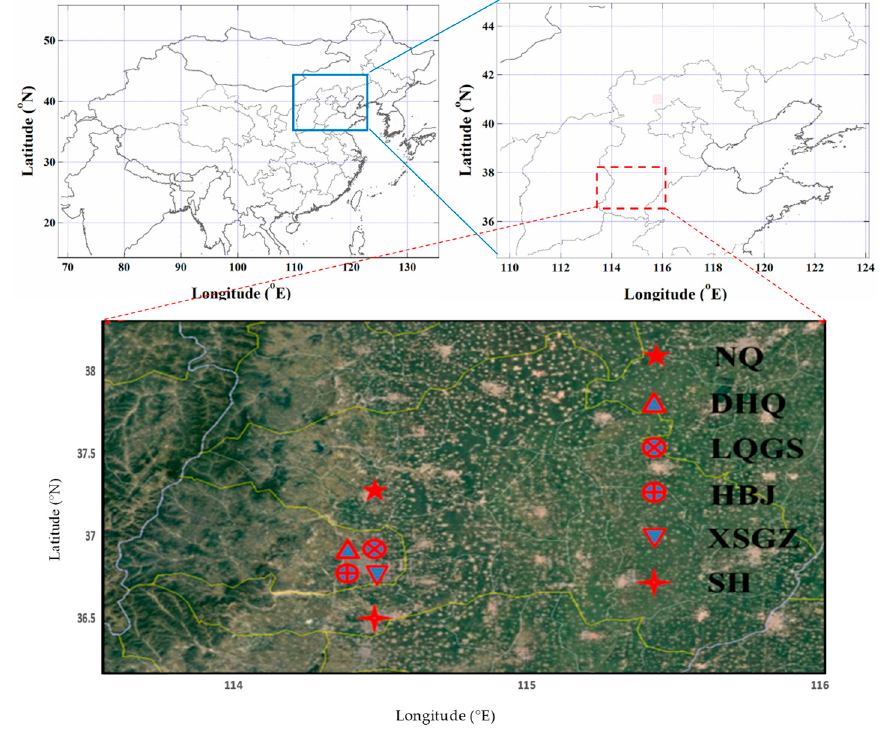
Figure 1. Location of the sampling sites in Xingtai.